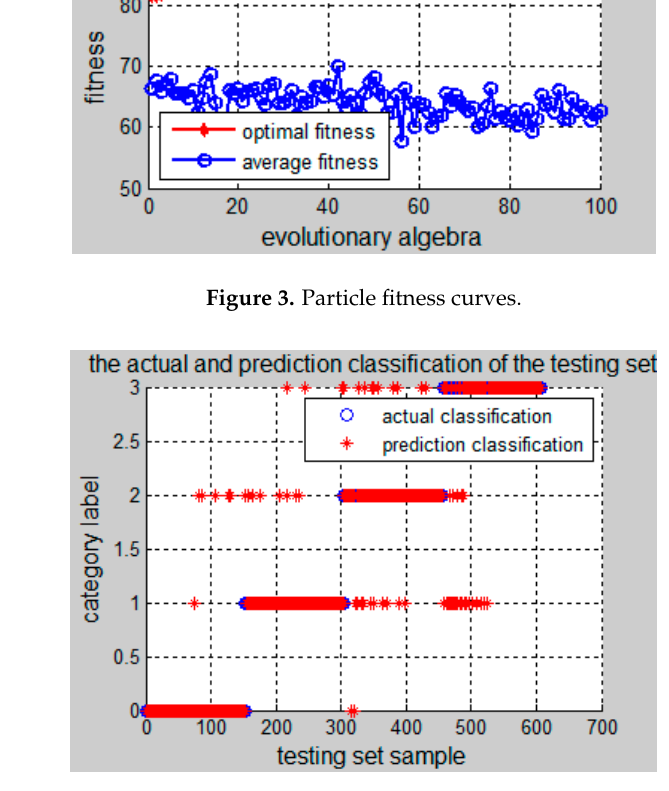
Figure 4. PSO-SVM testing results. Table 5. Comparison of PSO-SVM with other commonly used